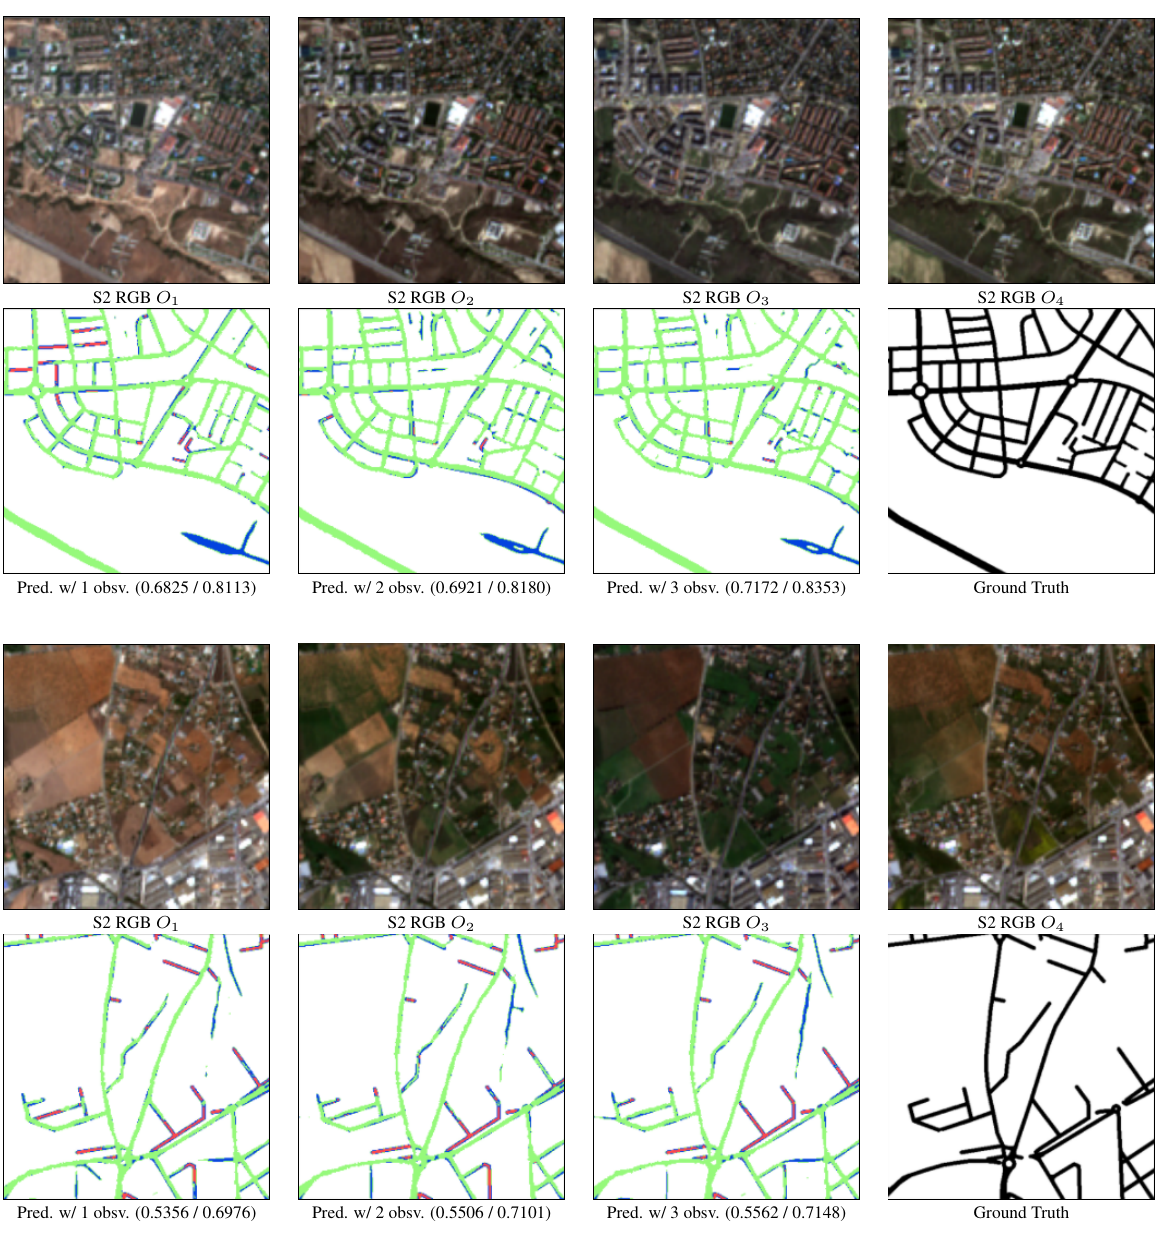
Figure 6. Visual comparison of the results obtained for the road network extraction task. Predictions are performed for the 4th observation ( O 4 ) when trained using 1, 2, and 3 observations for two zones randomly taken from the test set. True Positives (TP) are presented in green, False Positives (FP) in blue, False Positives (FP) in red, and True Negatives (TN) in white. Moreover, the IoU and F-score metrics have been